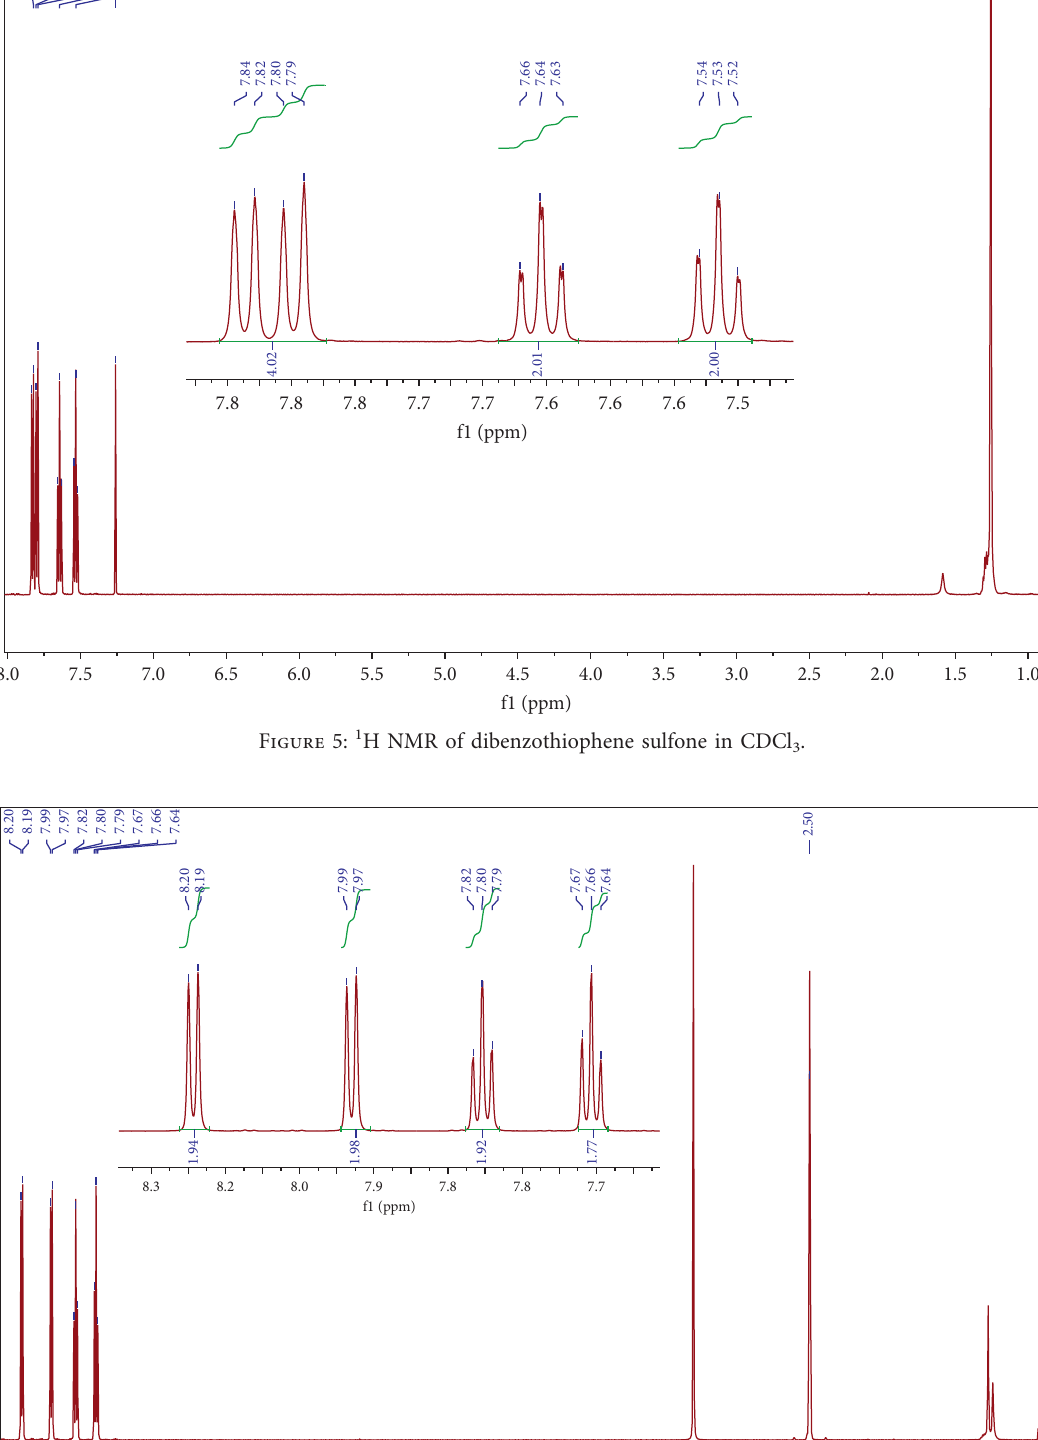
Figure 6: 1 H NMR of dibenzothiophene sulfone in (CD